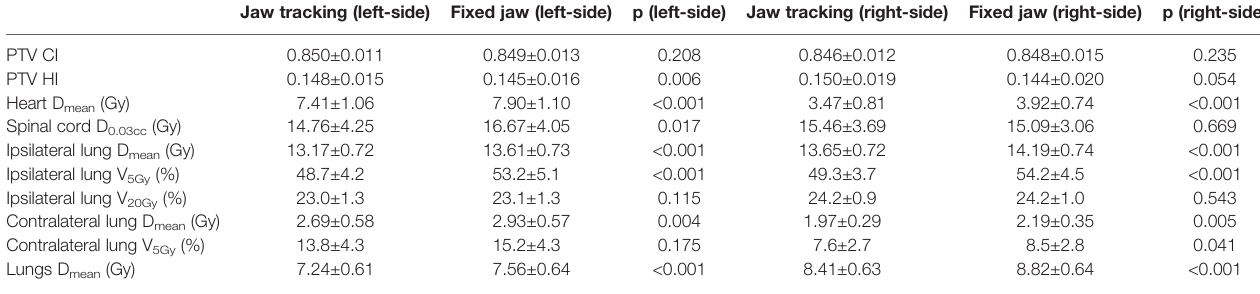
TABLE 7 | Dosimetric results (mean ± standard deviation) of postmastectomy VMAT plans with jaw tracking and fi xed jaw. Jaw tracking (left-side) Fixed jaw (left-side) p (left-side) Jaw tracking (right-side) Fixed jaw (right-side) p (right-side) PTV